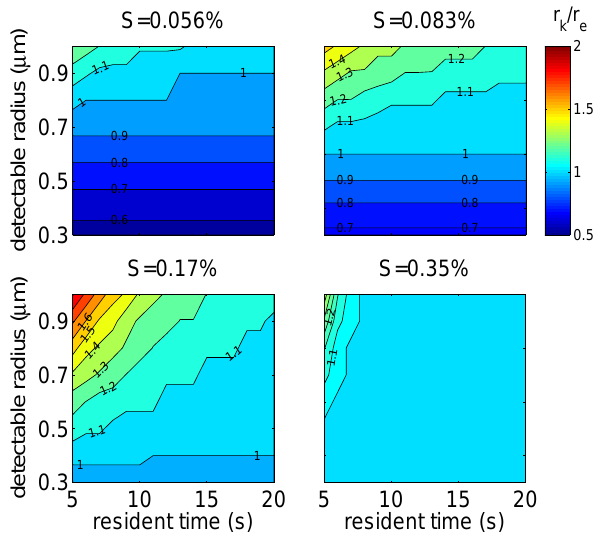
Fig. 6. Variation of r k / r e at different resident times and de- tectable radii for different supersaturations. r k represents the small- est aerosol radius that can grow larger than the detectable radius after the resident time in the counter based on the kinetic model, while r e represents the smallest activated radius calculated with the equilibrium model. The isopleths are stepped because the detectable radius varies from 0.3 to 1.0µm with an interval of 0.1µm, and the resident time varies from 5 to 20s with interval of 1s. In addition, the aerosol size distribution is represented with discrete bins.